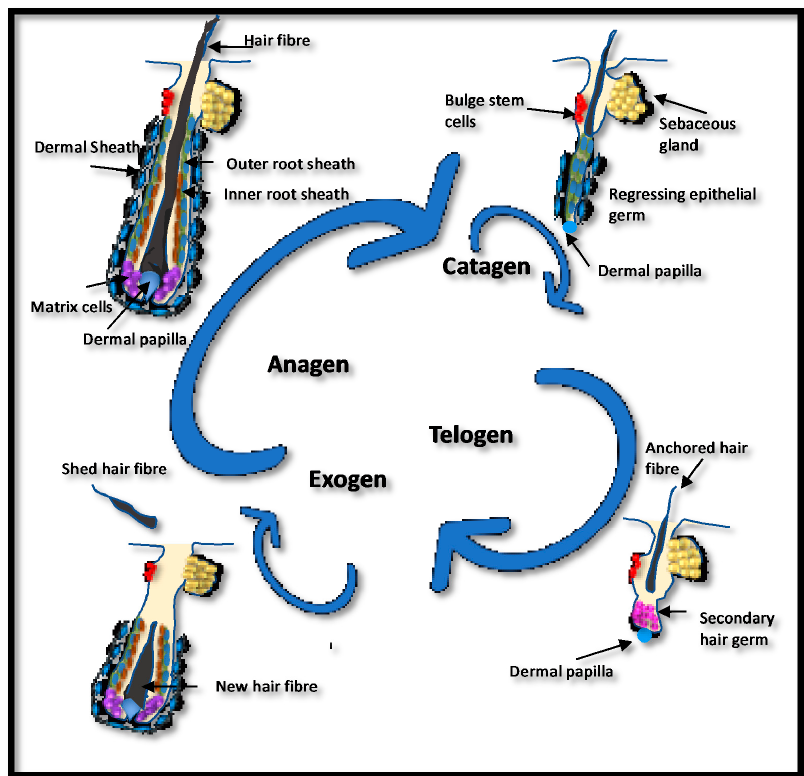
Figure 3. The human hair cycle. Hair follicles cycle throughout life with a growing phase (anagen) followed by regression (catagen) and maintenance (telogen). The hair fiber is shed during exogen, which usually coincides with the start of a new cycle. Bulb matrix cells proliferate and di ff erentiate to produce the new follicle and hair fiber. In their center, the dermal papilla directs the type of hair produced. During catagen, the lower hair follicle regresses before entering telogen, where the hair fiber is firmly anchored but no further growth occurs. The length of anagen and telogen vary and follicle may sit empty, a stage known as kenogen. Shortened anagen, lengthened telogen and